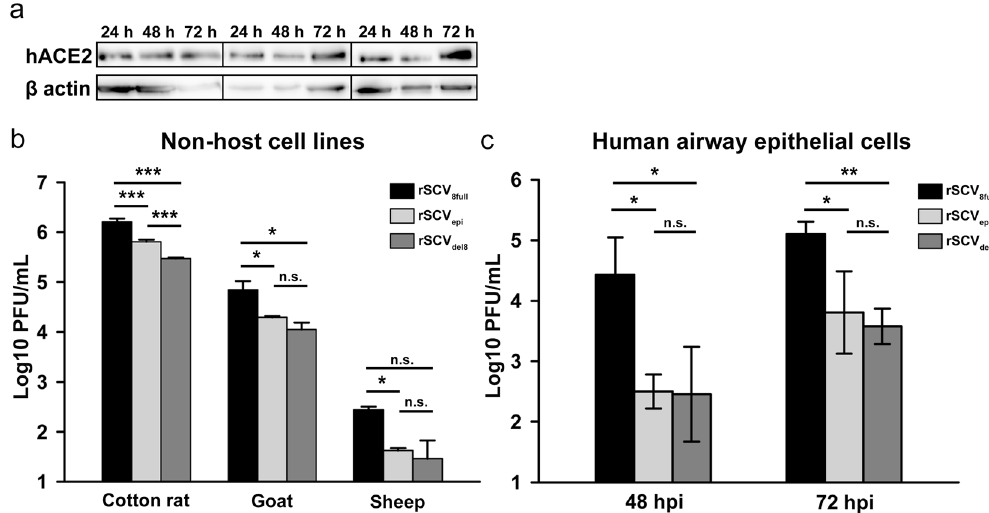
Figure 4. Replication of ORF8 variants in different “non-SARS-CoV-host” cell lines and differentiated human airway epithelial cells. ( a ) Cotton rat, goat, and sheep cells were transduced with lentiviruses to transiently express the SARS-CoV receptor hACE2 for at least 72 h. Expression of hACE2 was verified by Western Blot analysis, detection of β actin served as a loading control. To improve clarity blots were cropped. Full length blots are presented in Supplementary Fig. S1. ( b ) Cells were infected in triplicates with different ORF8 variants at MOI 0.001 24 h after lentiviral transduction, 24 hpi supernatants were sampled and virus replication determined by plaque titration. ( c ) Differentiated human airway epithelial cells were infected in triplicates at MOI = 0.1, supernatants were sampled at 48 and 72 hpi for plaque titration. The experiment was done twice. Shown is one representative experiment. Error bars represent standard deviation of the mean. Significance of replication differences between virus variants was determined by t-Test ( *** p ≤ 0.001, ** p ≤ 0.001, * p ≤ 0.05, n.s., not significant p >